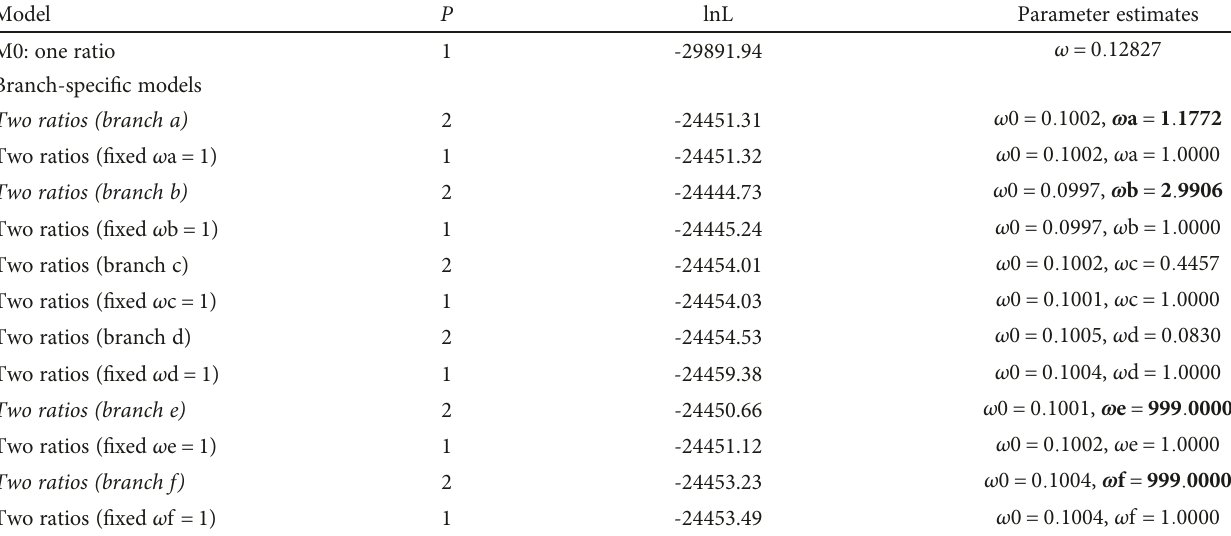
Table 4: Parameter estimation and likelihood ratio tests for the two-ratio